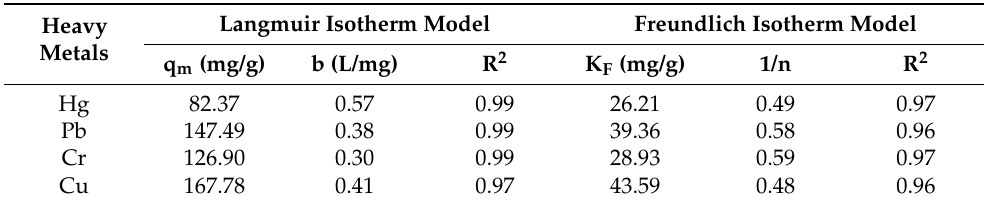
Table 2. Isotherm parameters of heavy metal adsorption on Melanin. Adapted from [185] with minor